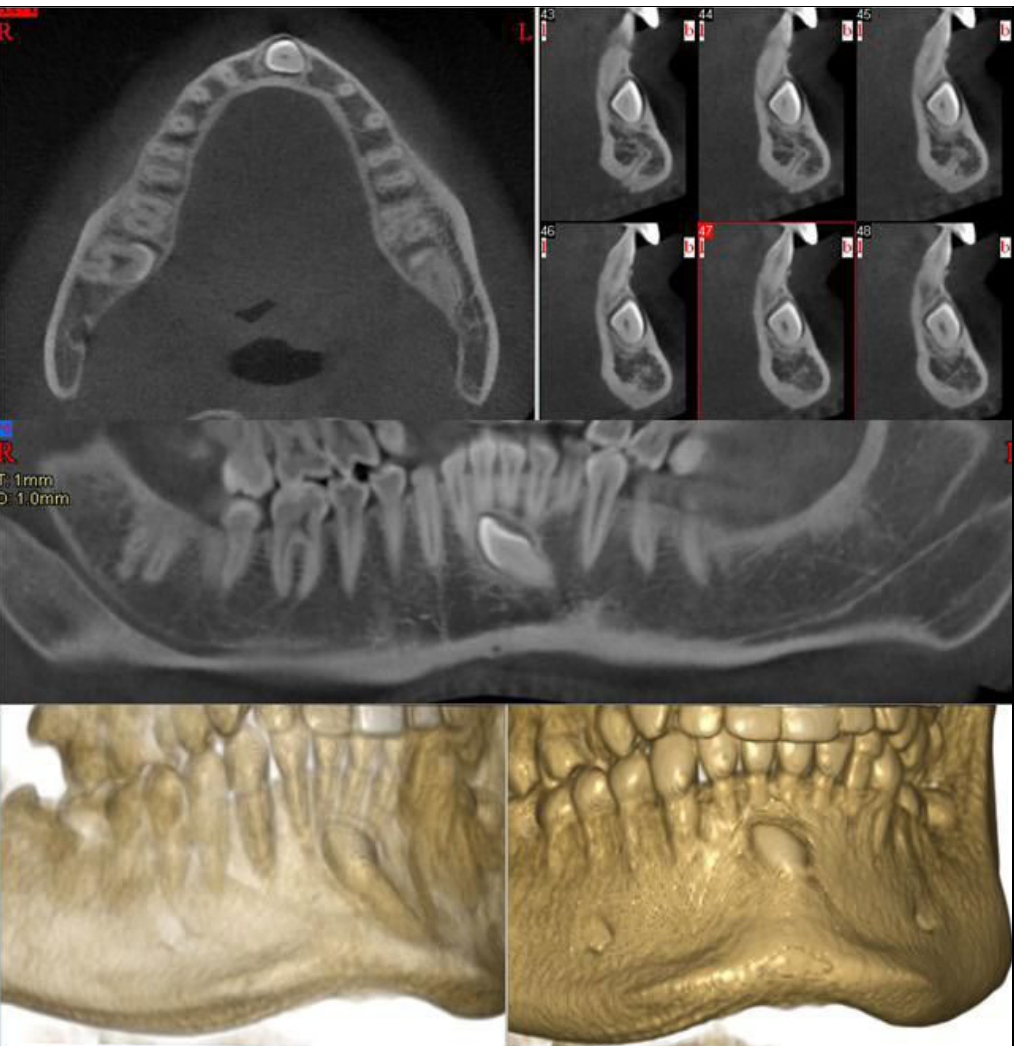
Figure 6. The CBCT axial, paraxial slices and 3D images revealed transmigration of the mandibular left canine.